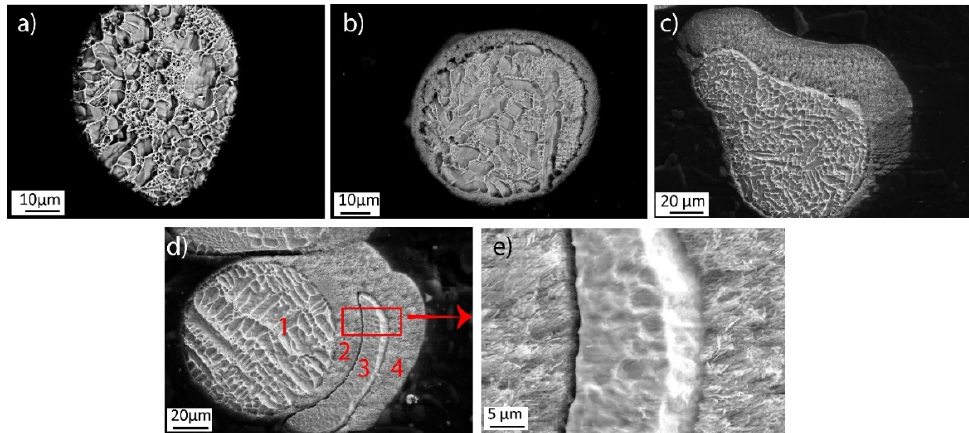
Figure 4. A comparison of condensate deposited on the surface of spatters: ( a ) spatter particle without condensate, ( b ) spatter particle with a condensate of approximately 5–10 µ m thickness, ( c ) spatter particle with a condensate thickness of approximately 40 μ m, ( d ) multiple layers of condensate and spatter, and ( e ) high-magnification inset from ( d ).